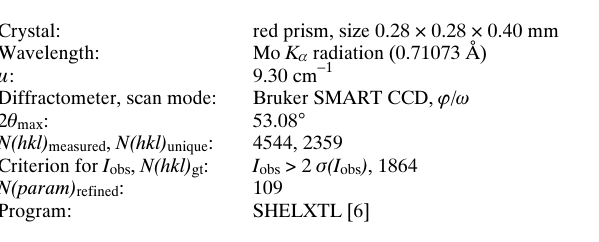
Table 1. Data collection and handling.